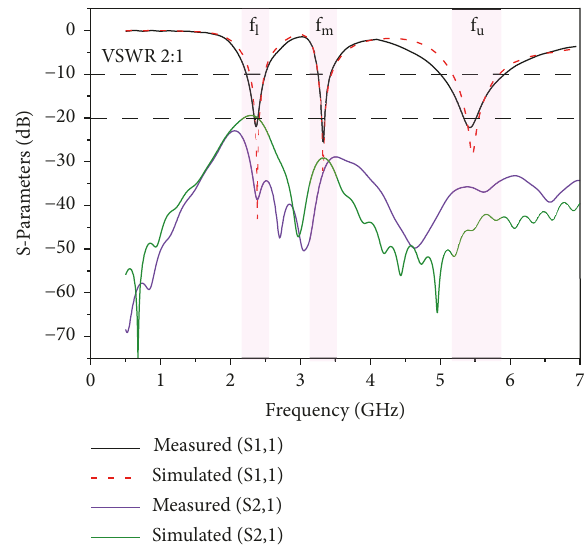
Figure 12: Simulated and Measured S parameters of proposed MIMO